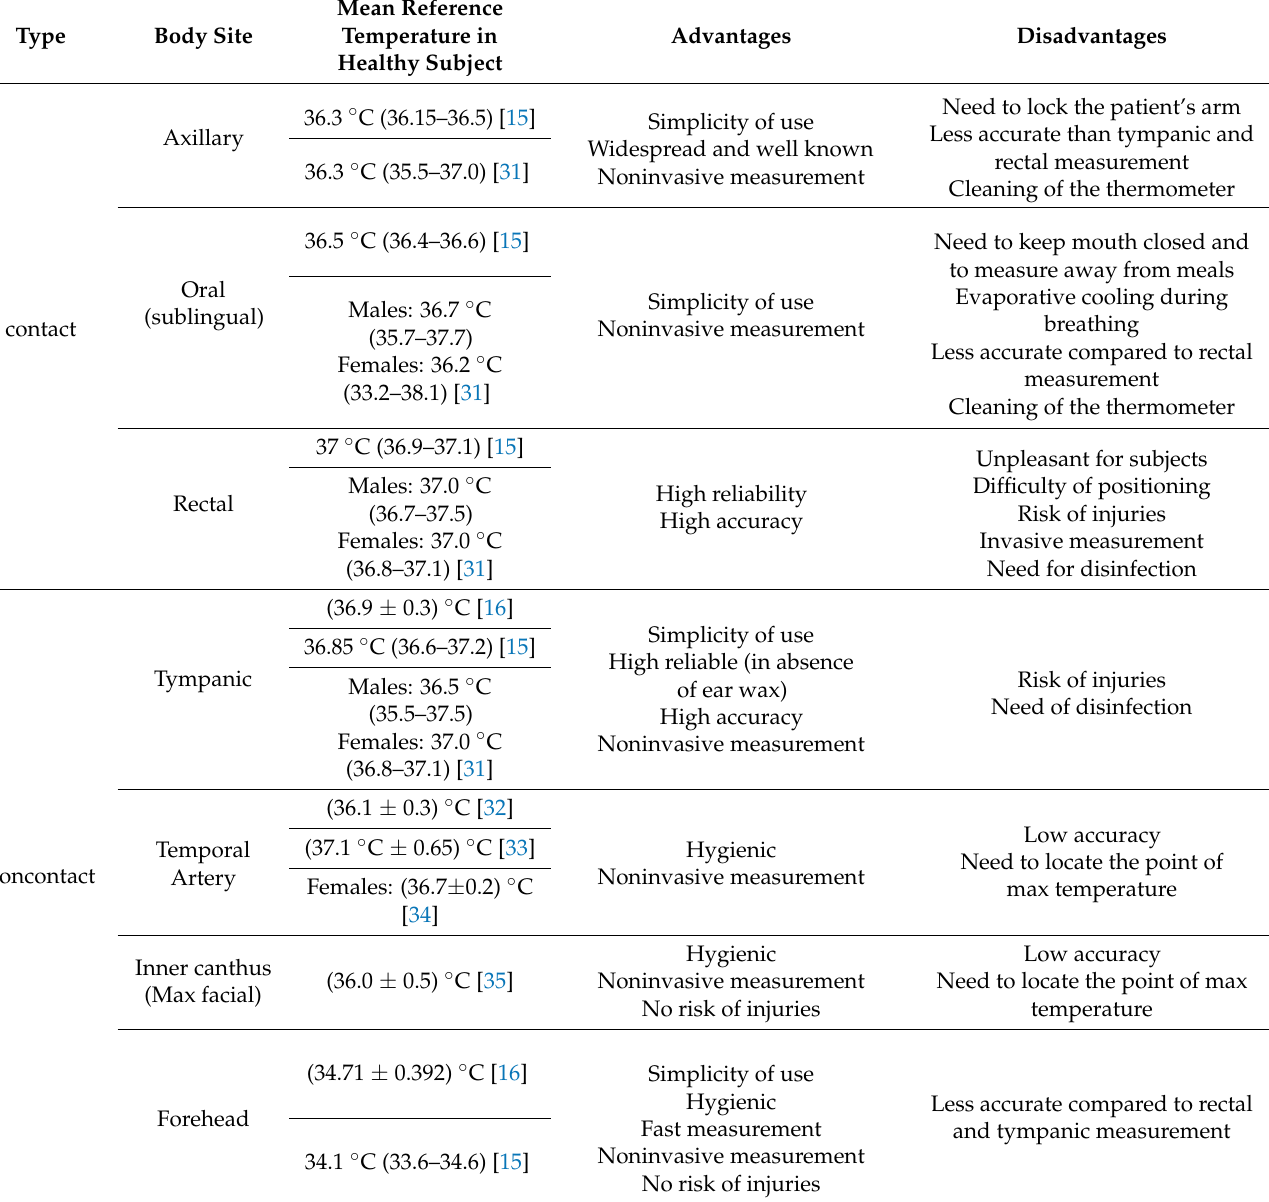
Table 1. Body temperature measurement site